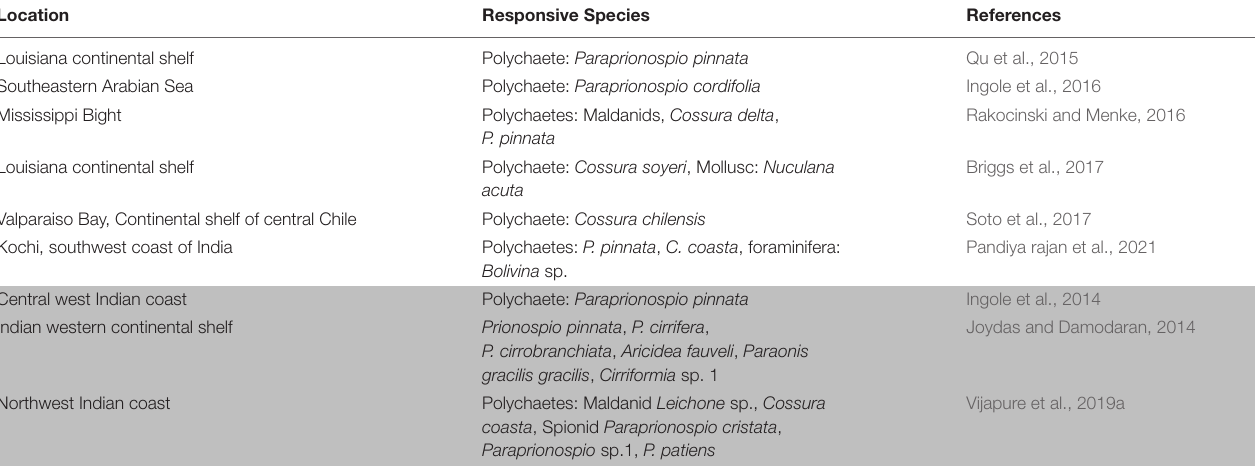
TABLE 2 | Responsive species to hypoxia in different geographical settings (Shaded region indicates studies from NWI).